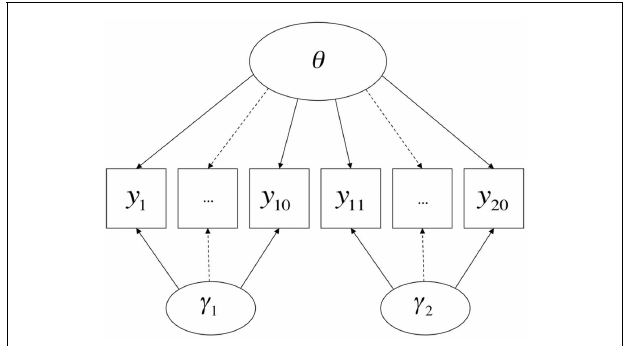
FIGURE 3 | Item types as method factors.